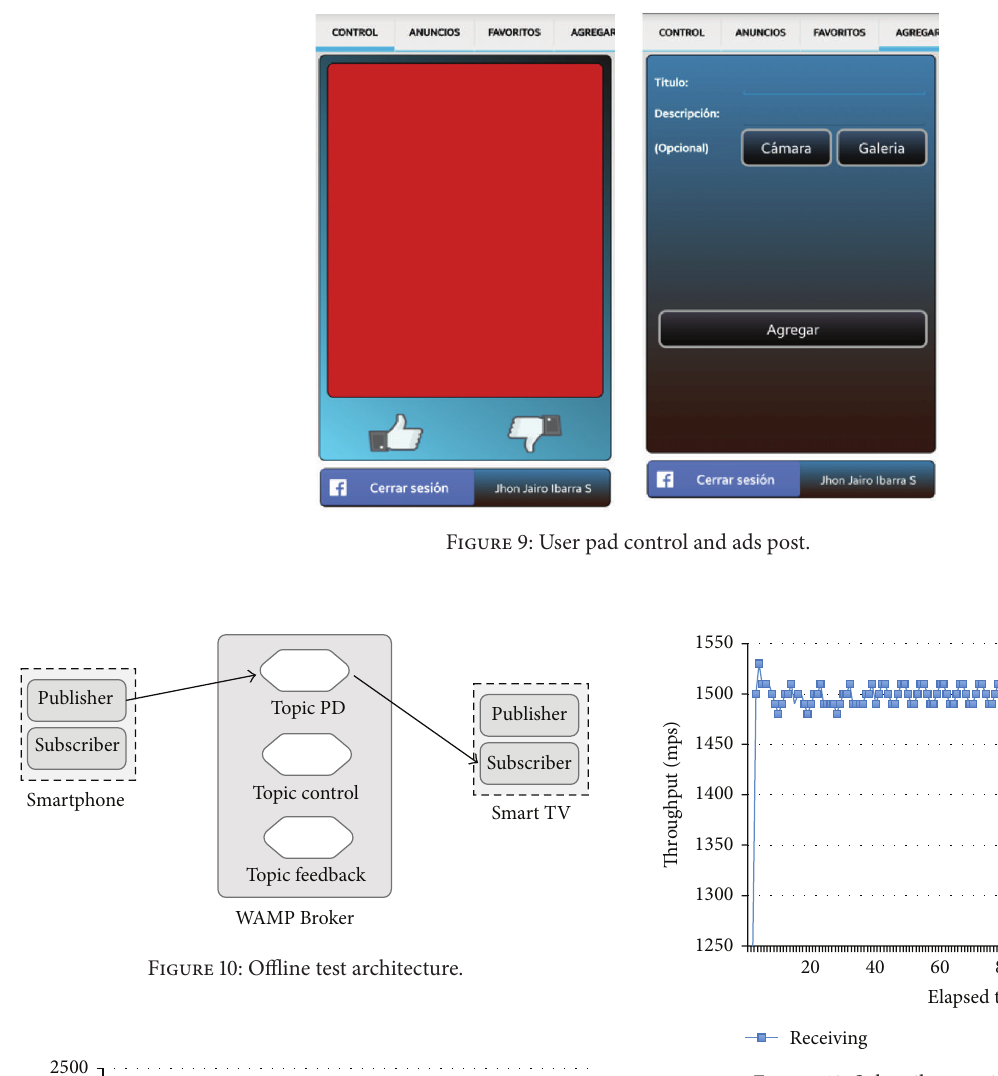
Figure 12: Subscriber receiving rate at